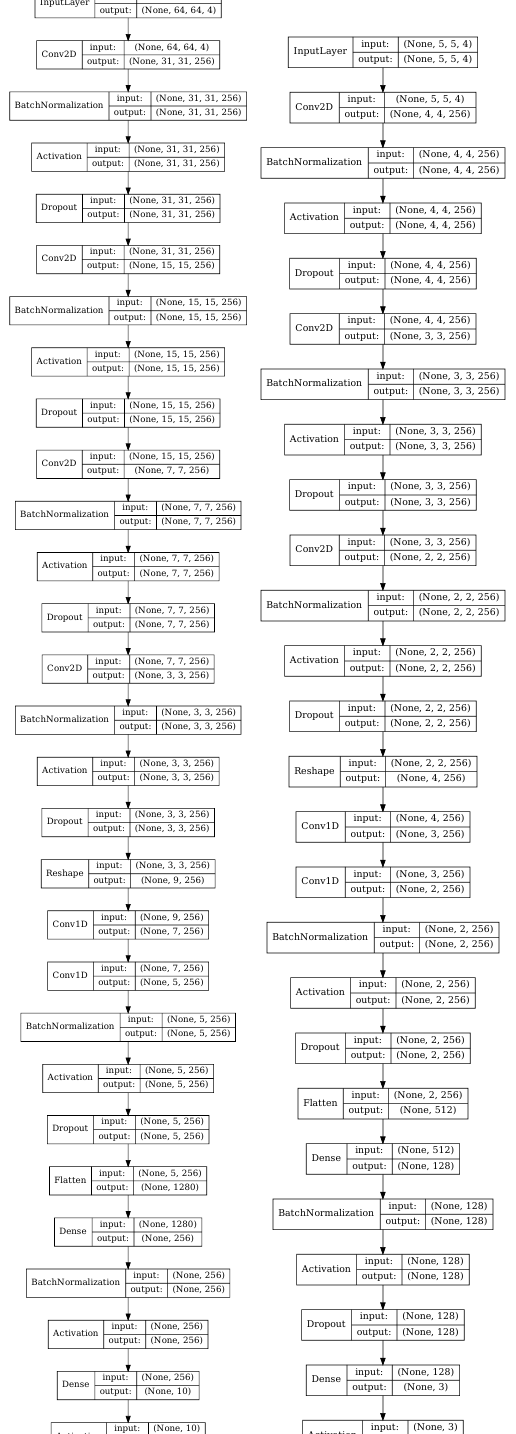
Figure 4. Two independent CNN topologies: the left one performs a patch-based classification and the right one a pixel-wise